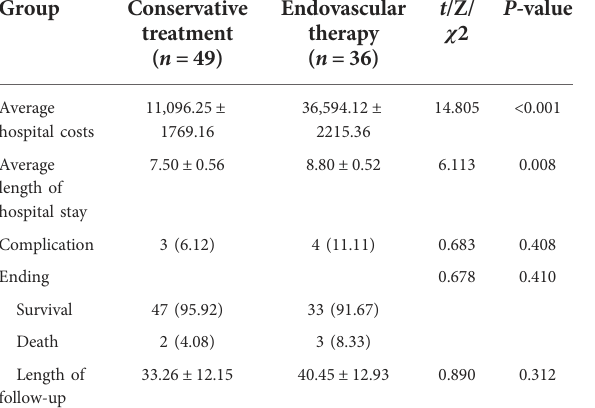
TABLE 5 Comparison of follow-up data of two groups of patients. Group